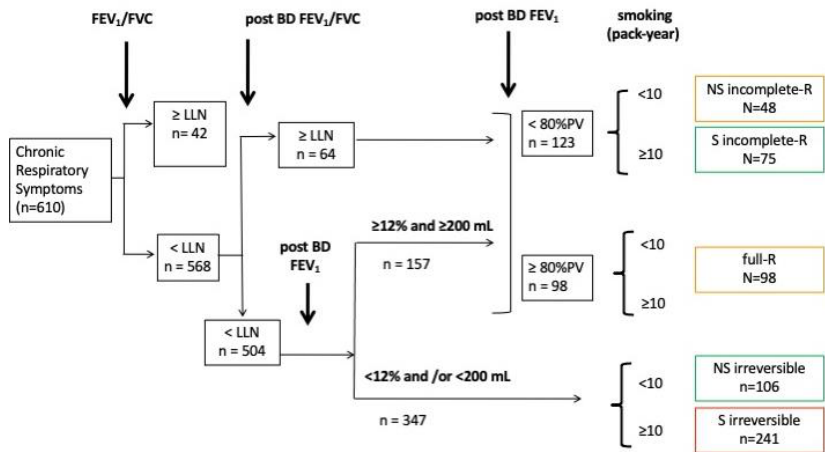
Figure 1. Definition and prevalence of 5 phenotypes of obstructive airway diseases. FEV 1 : forced expiratory volume in 1 s; FVC: forced vital capacity. BD: bronchodilator; COPD: chronic obstructive pulmonary disease. NS: Non-Smoker. S: Smoker. PV: Predicted Value. -R: Responder. The BD response of both FEV 1 /FVC and FEV 1 to salbutamol (400 mcg) inhalation was defined